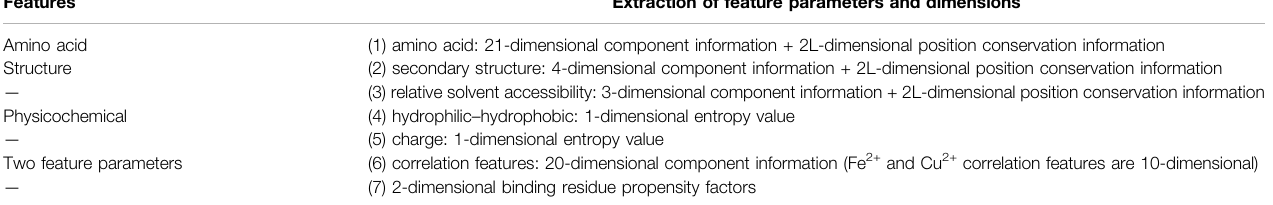
TABLE 4 | A summary of prediction parameters. Features Extraction of feature parameters and dimensions